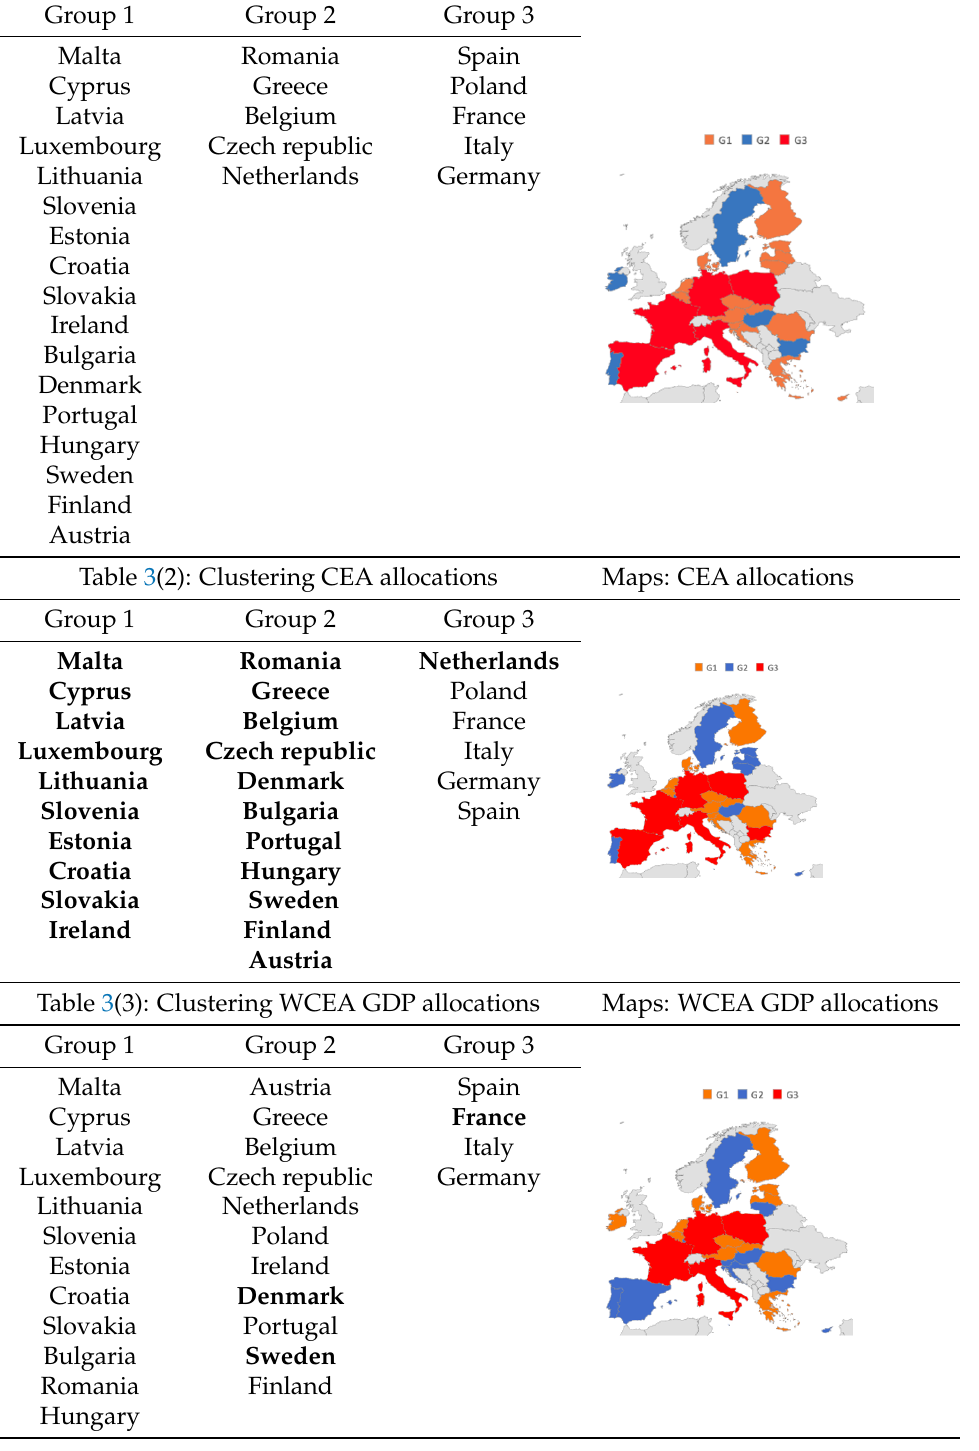
Table 3. Outcomes of the K-means clustering application over allocation records provided by alternative allocation methods. Names in bold indicate countries that are totally satisfied at least for 3 years. Table 3(1): Clustering EU country emissions Maps: EU country emissions